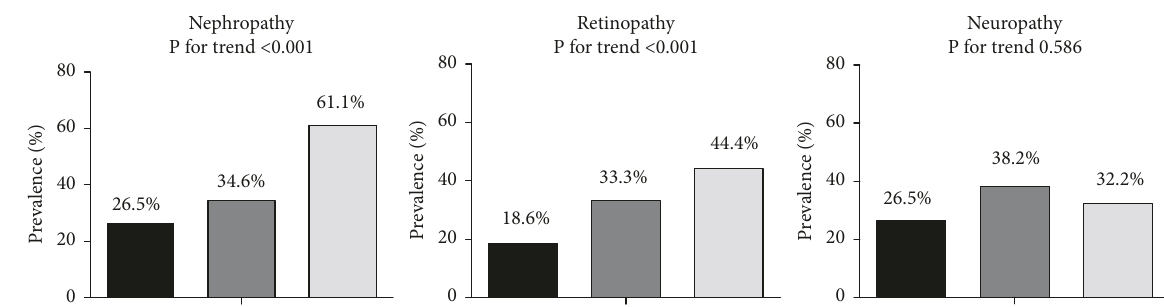
Figure1: Theproportionofpatientswithmicrovascularcomplicationsacrosstertilesofchemerin .Asshown,significantdifferencesacrosstertiles of plasma chemerin were seen for nephropathy and retinopathy, whereas no changes were seen for neuropathy. P for trend among all three tertiles is presented. P-value for significant difference between the groups was determined by the one-way analysis of variance (ANOVA).